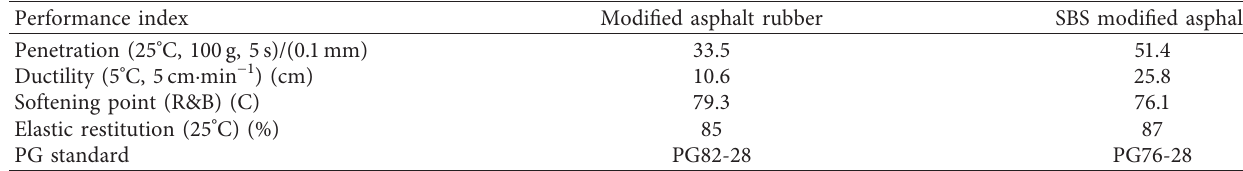
Table 8: Comparison of the performance indices of modified asphalt rubber and SBS modified asphalt.